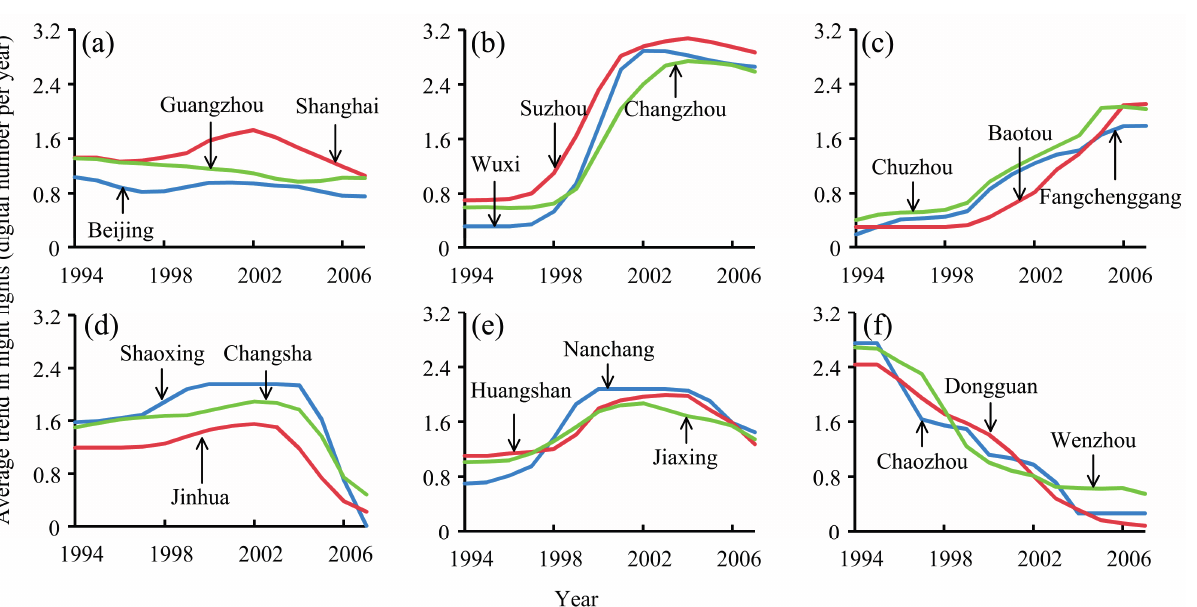
Figure 9. Diverse average trends: stable ( a ), positive ( b , c ), negative ( d ), convex ( e ) and negative ( f ) in night light growth for 18 Chinese cities from 1994 to